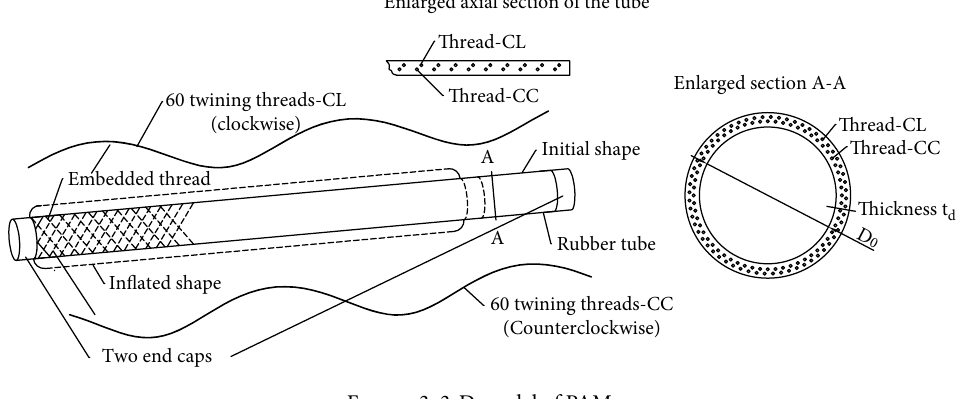
Figure 3: 3-D model of